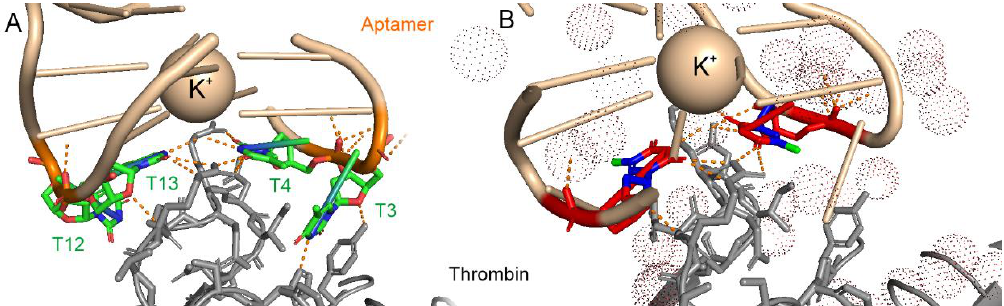
Figure 1. The interface of the HD1-thrombin complex (the structure was built from pdb id 4dii [19]); the aptamer is shown in light-brown; thrombin is shown in grey). ( A ) The recognizing loops are colored in green; the positions of T3, T4, T12, and T13 nucleotides are labeled; the polar contacts formed by these nucleotides are shown as dashed lines. ( B ) T4 and T13 are shown in color; the non-polar core is in blue and green colors; the methyl group in 5th position is shown in green. The solvent molecules are shown as transparent balls. The methyl group is faced toward the solvent; it was chosen as a site for further modifications.